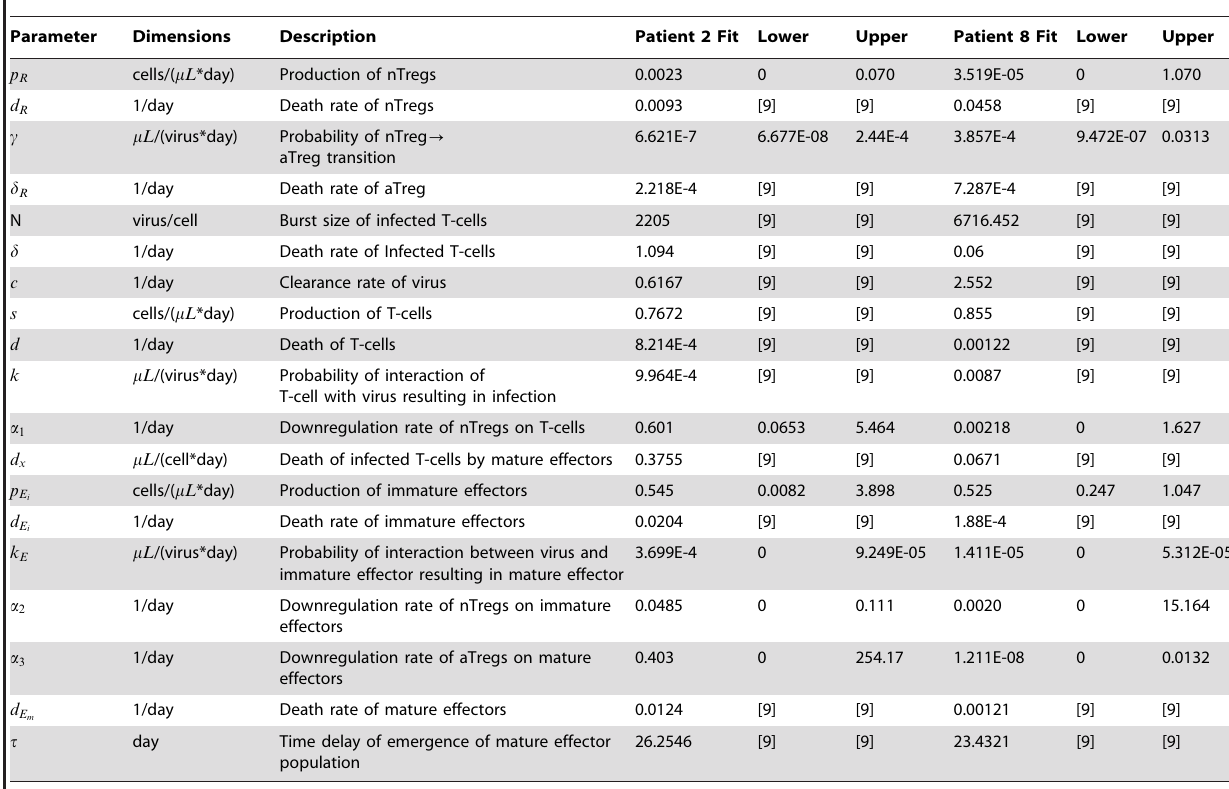
Table 1. Treg model parameter ranges and